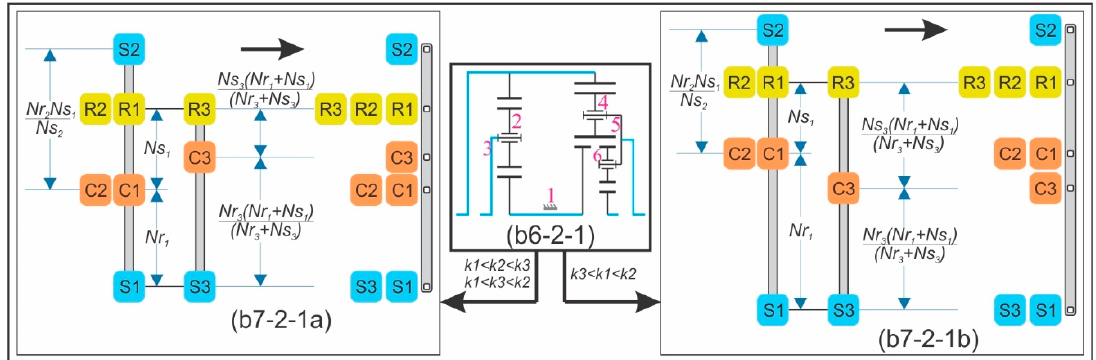
Figure 11. Conversion of transmission mechanisms into compound analogous levers.